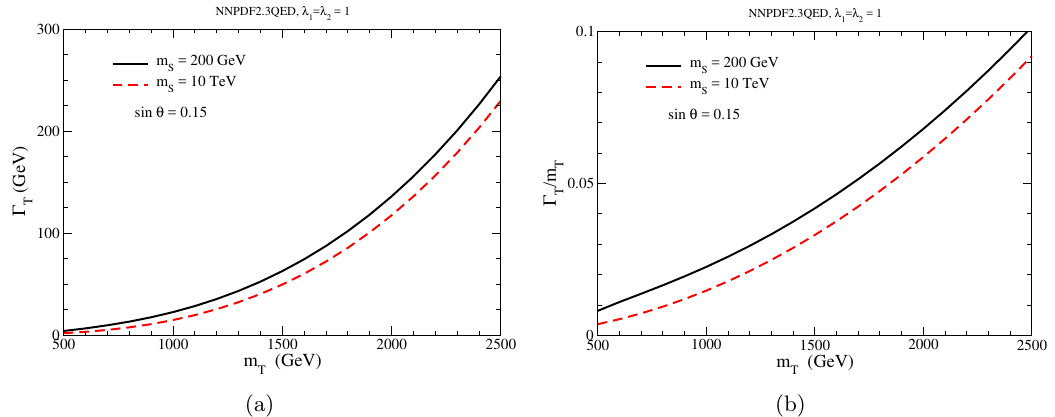
Figure 12 . (a) Total width of top partner and (b) width to mass ratio for (cid:21) 1 ; 2 = 1, sin (cid:18) L = 0 : 15, and (black solid) m S = 200 GeV and (red dashed) m S = 10